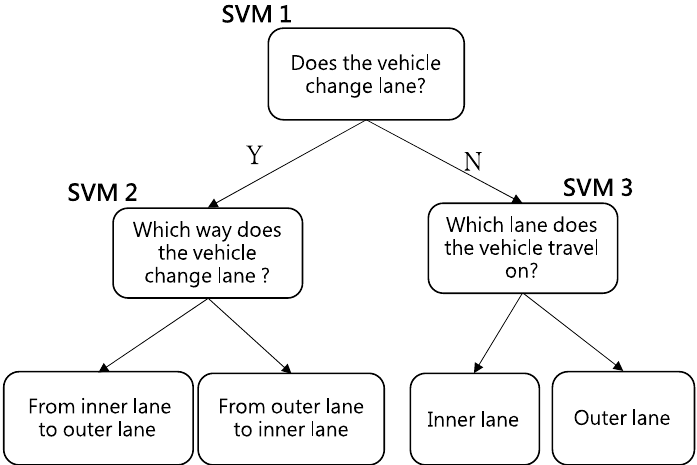
Figure 14. The hierarchical SVM structure proposed for solving LIP. SVM 1: Classifying lane-changing behavior. SVM 2: If the vehicle changes a lane, determine which route the vehicle moved. SVM 3: If the vehicle is in a fixed lane, determine if it is in the interior or the exterior lane. The average collected signal strengths were − 85.44, − 85.74, and − 84.15 for RSSI using Bluetooth sniffers, and − 17.46, − 20.0, and − 24.91 for RSSI using Wi-Fi on rectangle, X-type, and diamond-type topologies, respectively. The accuracies for the LIP are shown in Figure 15, which is summarized by 10-fold cross validation. The overall accuracy can be estimated by the average accuracy composite of higher SVM and lower level SVM (average of SVM1 × SVM2 and SVM1 × SVM3). For BT, the accuracy in identifying four cases of lane-changing behaviors was about 45.4%, 44.9%, and 39.6% in the X-type, rectangle-type, and diamond-type topologies, respectively. For the Wi-Fi, the accuracy in identifying four cases of lane-changing behaviors is 34%, 27.3%, and 45.4% in the X-type, rectangle-type, and diamond-type topologies, respectively. The results show that the X-type topology is superior to the others in BT. In the three classifiers, the accuracy in identifying the fixed lane (SVM 3) was about 80%, showing that the signal of the fixed lane varies regularly and could be classified